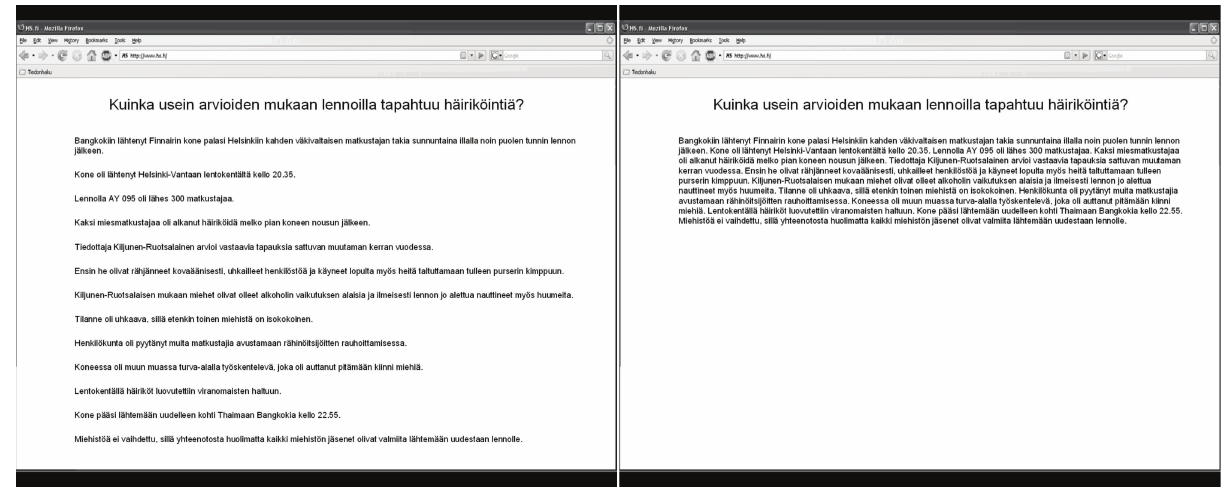
Figure 3: Two alternative ways to represent textual information on an in-vehicle